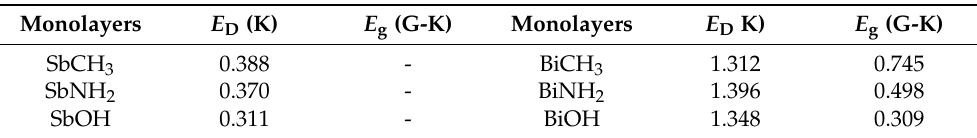
Table 2. The SOC-introduced Dirac-cone splitting-gaps at K point E D (K) and the resulted indirect band-gaps from K point to G point E g (G-K) of SbXH n and BiXH n . Monolayers Monolayers